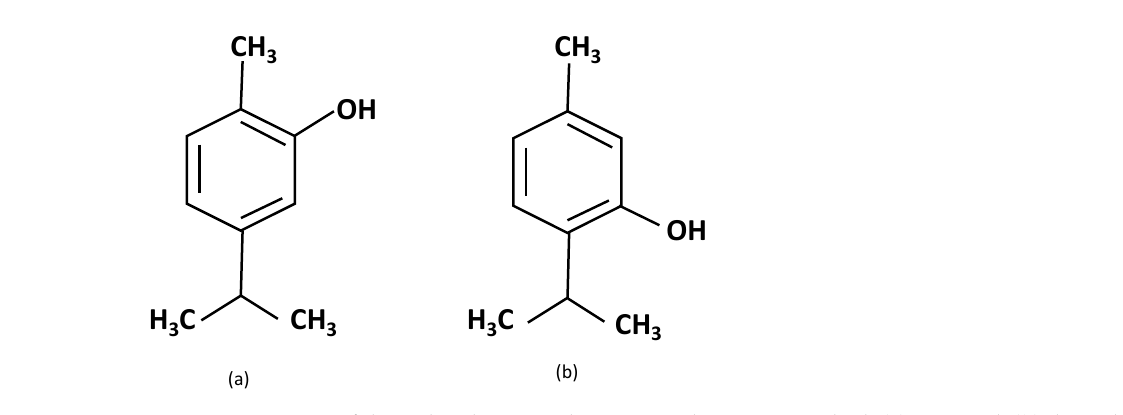
Table 1. Properties of the emulsions